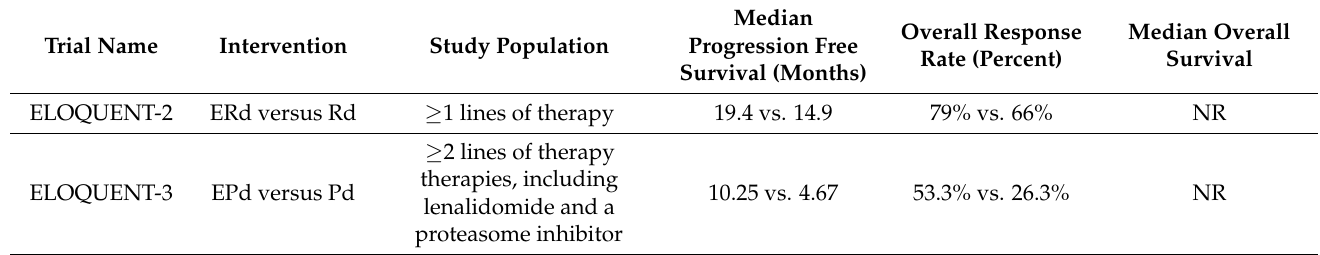
Table 5. Summary of Major Clinical Trials for FDA Approval of